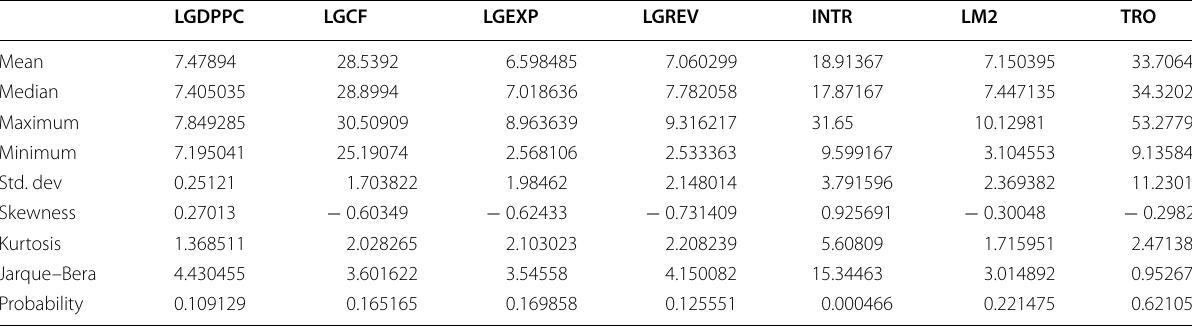
Table 2 Summary of statistics